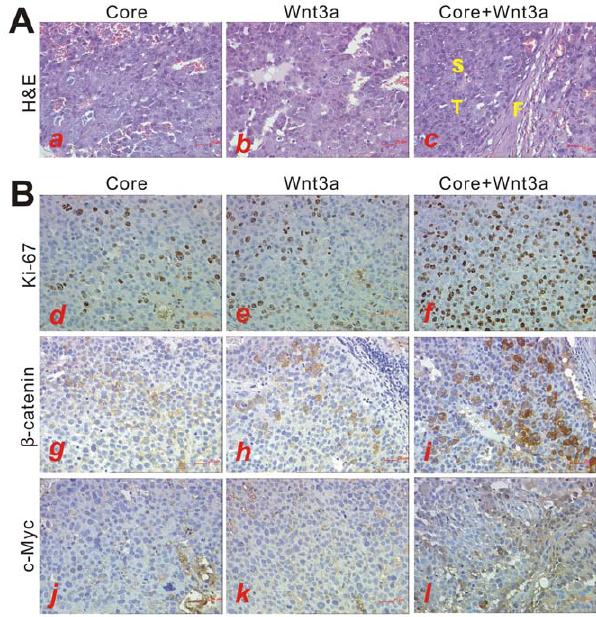
Figure 6. HCV core promotes cell proliferation in xenograft tumors. Retrieved tumor samples (from Figure 5) were fixed and subjected to histological evaluation. ( A ) Hematoxylin& eosin staining of tumors (panels a to c ), showing examples of tumor cells surrounded by fibrous connective tissue. S, Sinusoid. F, Fibrous connective tissue. T, tumor cells. Magnification, 6 400. ( B ) Immunohistochemical detection of Ki67 ( d to f ), b -catenin ( g to i ) and c-Myc ( j to l ) in xenograft tumor samples. The positive cells stained brown. Representative images are shown (Paraffin section; 6 400).